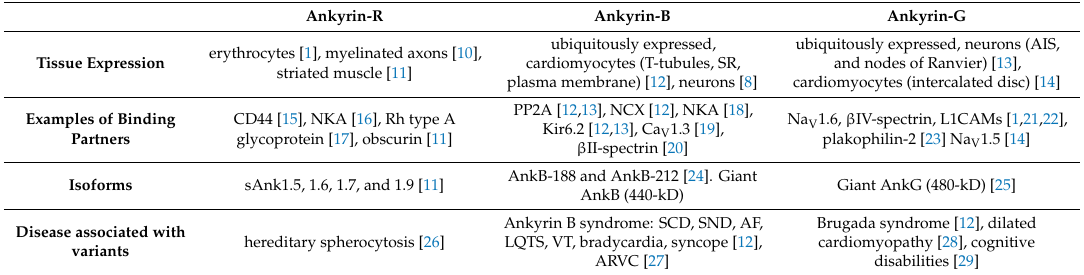
Table 1. Brief summary of ankyrin family proteins: ankyrin-R, ankyrin-B, ankyrin-G. Ankyrin-R Ankyrin-B